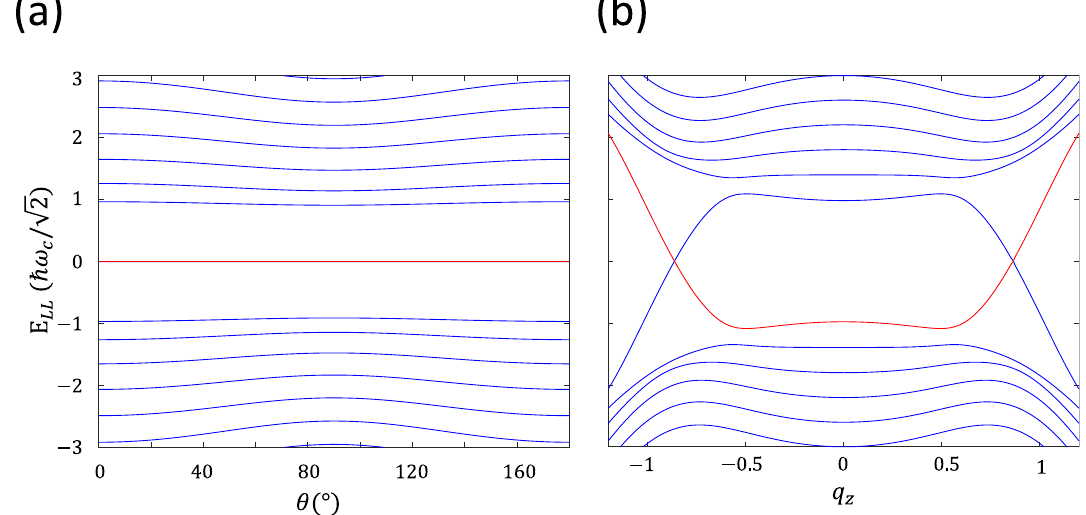
0.05 , v 0.3125 for the 0.5 , and v 0.2 and 0.4 so that α z α y Figure 5. ( a ) The case of α y / v x = z / v x = = ˜ = ˜ = 0.8 and k 0 , the zero Landau energies persist in model Hamiltonian H ′ B is presented. With fixed value of g ′ z = = all rotated angles θ . ( b ) The k z / k V dispersion along the field direction is presented for the Hamiltonian H ′ B with 0.05 , v 0.5 , k W / k V 0.2 . The field strength and direction are chosen to ˜ parameters to be α y / v x = v z / v x = = = 0.8 and rotated angle θ 30 have g ◦ = =